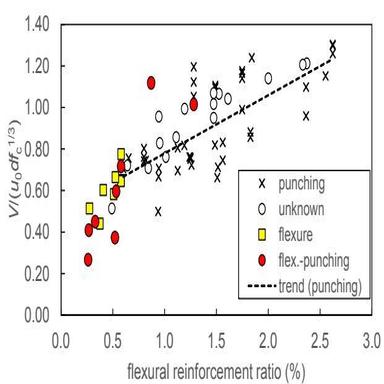
Normalized experimental failure loads as a function of the flexural reinforcement ratio in HSC specimens without shear reinforcement.